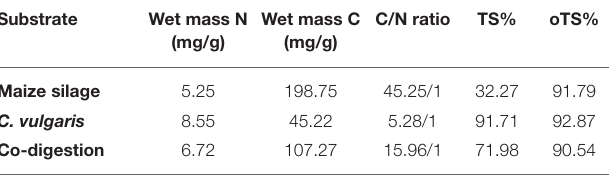
TABLE 1 | Characterization of the feedstocks used in the experiment.